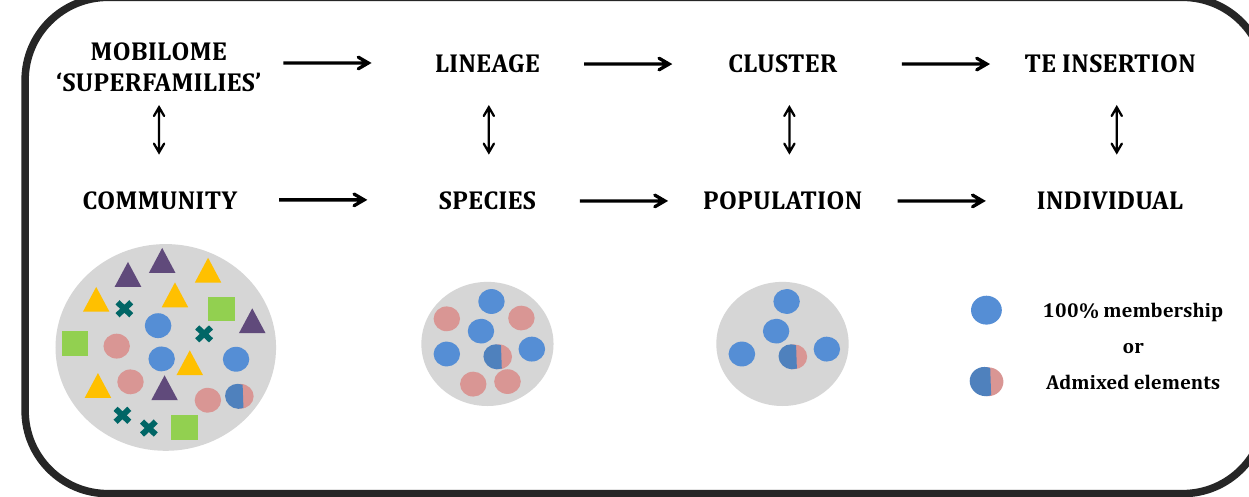
Fig 1. Hierarchical levels of the classification of TEs and the equivalent population genetics terminology used in this work. Shapes represent lineages, and colors represent the genetic information of a TE insertion. Elements with the same color belong to the same population (cluster). Elements with only one color are 100% membership, and elements with more than one color are